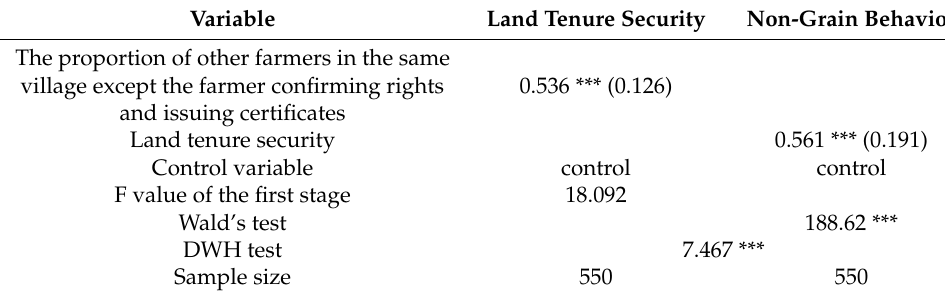
Table 3. Instrumental variable test.